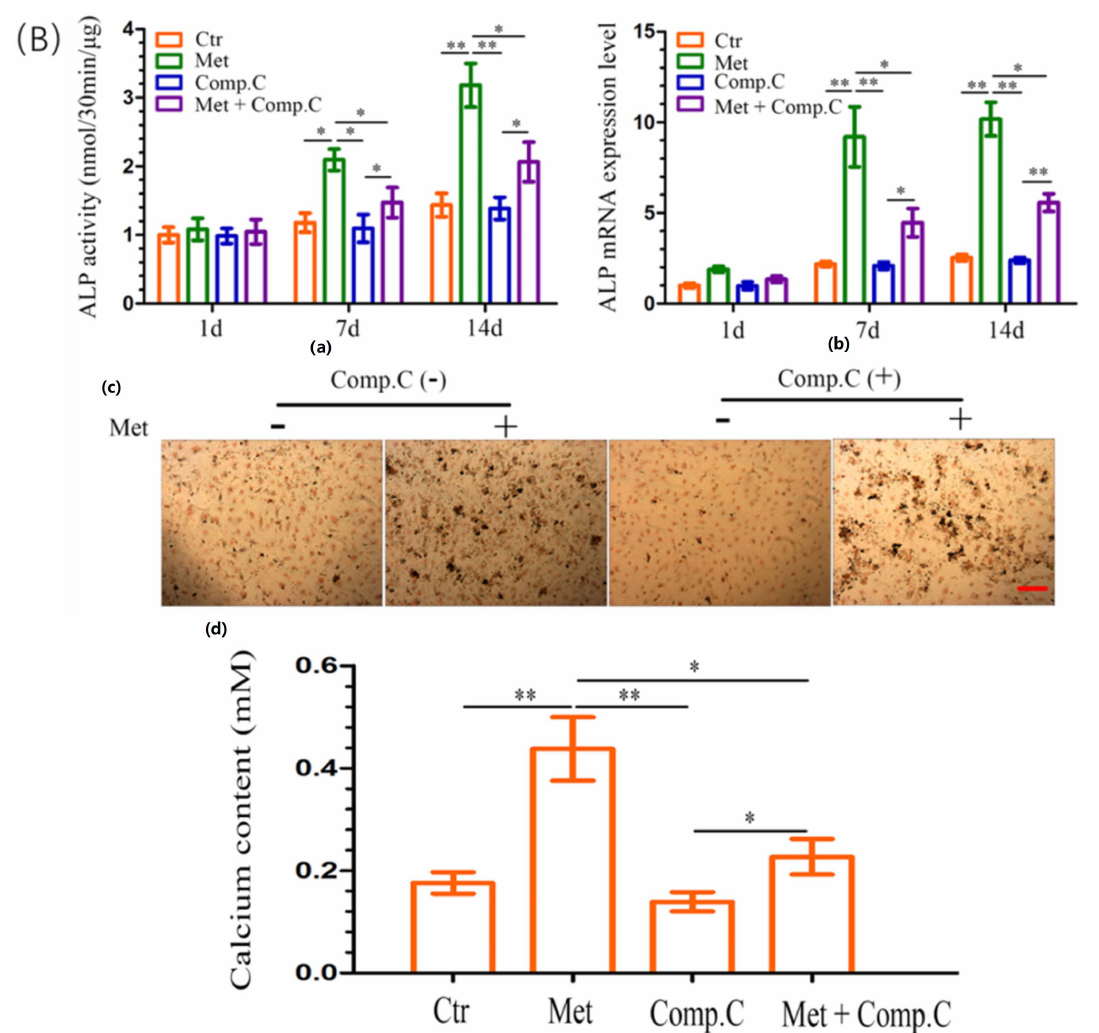
Figure 6. The effects of metformin on dental pulp cells (DPCs). ( A ) Effect of metformin on cell viability and proliferation of DPCs. ( a ) Representative live/dead images of metformin-treated DPCs at days 1 and 7 of culture, with live cells stained green and dead cells shown in red. In all four groups, live cells were abundant, and dead cells were few (scale bar = 100 µ m). ( b ) Percentage of live cells of DPCs was around 90%. Data represent mean ± SD of 3 experiments with triplicates. ( c ) All groups exhibited increasing live cell density. Data represent mean ± SD of 3 experiments with triplicates. * p < 0.05. (d) Metformin has no effect on the cell proliferation. Data represent mean ± SD of 3 experiments with triplicates. ( B ) Effect of metformin-induced ALP activity and mineralized nodule formation in DPCs. ( a , b ) DPCs were treated with metformin (50 µ M) in the absence or presence of Compound C (10 µ M, pretreatment for 1 h); cells were retreated every 3 days. ALP activity ( A ) and ALP mRNA expression ( b ) were measured at each time point. Data represent mean ± SD of 3 experiments with triplicates. * p < 0.05. ** p < 0.001. ( c ) DPCs were cultured in osteogenic induction medium for 14 days, mineralized nodule formation was assessed by von Kossa staining (scale bar = 100 µ m). ( d ) On the 14th day, the calcium content was determined. Data represent mean ± SD of 3 experiments